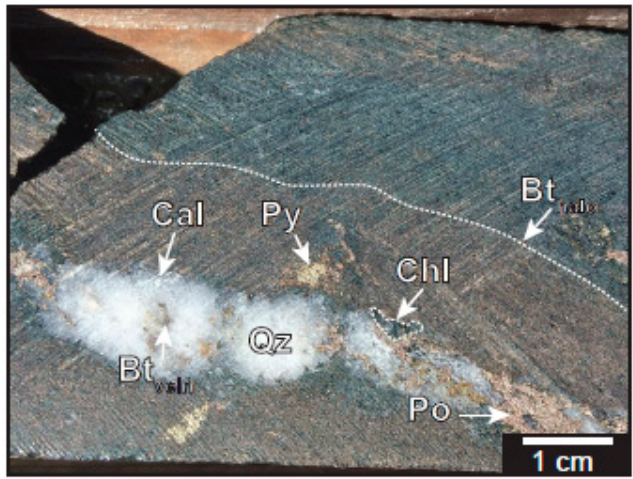
Figure 2. Photograph of a representative drill core showing mineralized pre- to syn-D 2 folded-sulfidized quartz-calcite-chlorite veins (V 5 ). Bt halo : biotite alteration adjacent to vein; Bt vein: biotite hosted within vein; Cal: calcite; Chl: chlorite; Po: pyrrhotite; Py: pyrite; Qz: quartz [22].